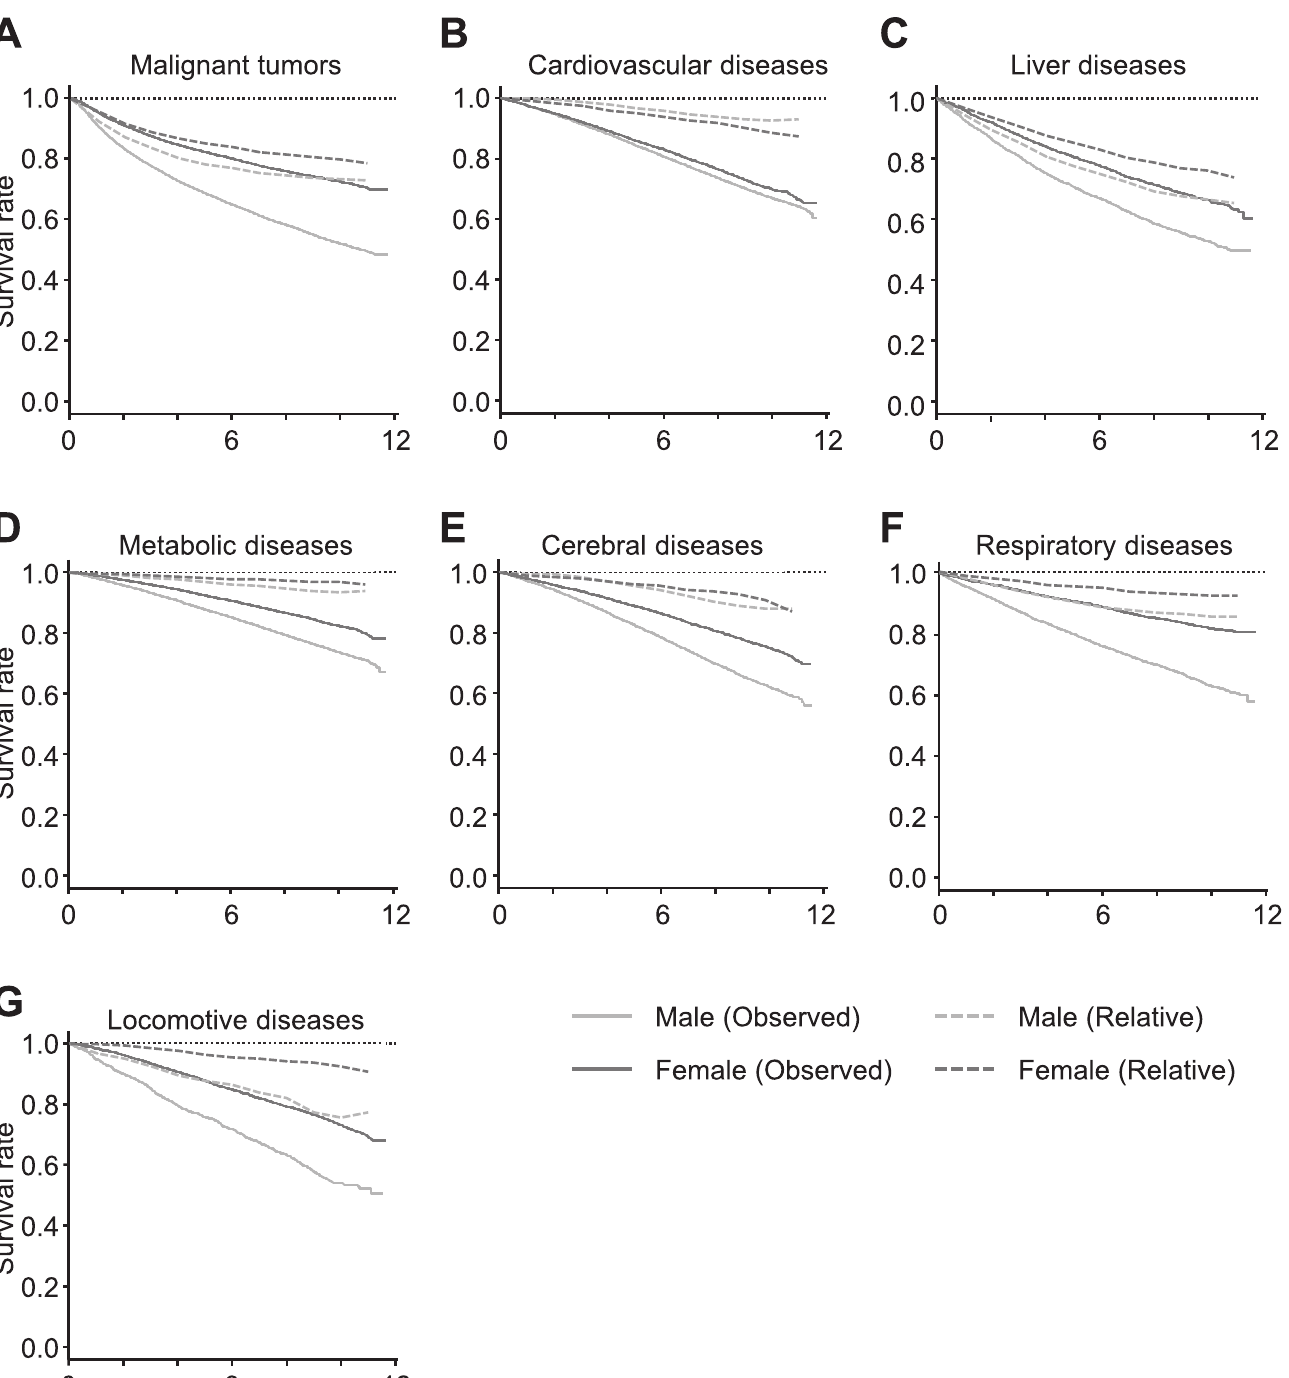
Fig. 2. Survival curves of patients by disease group. Observed cumulative survival curves (solid) and relative survival rates (dotted) of male and female BBJ patients for each disease group: Malignant neoplasms (A), Liver disease (B) , Respiratory disease (C) , Cardiovascular disease (D) , Cerebrovascular diseases (E) , Metabolic diseases (F) , and Locomotive diseases (G) . Observed cumulative survival curves were analyzed by Kaplan e Meier methods. Relative survival rates were estimated as the ratio of the observed cumulative survival rates of subjects to the expected survival